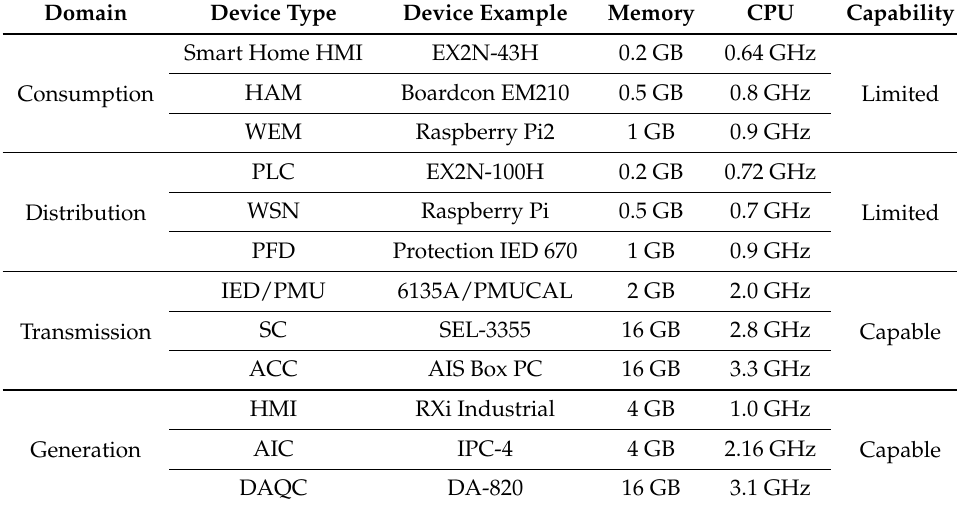
Table 1. Devices in smart grid